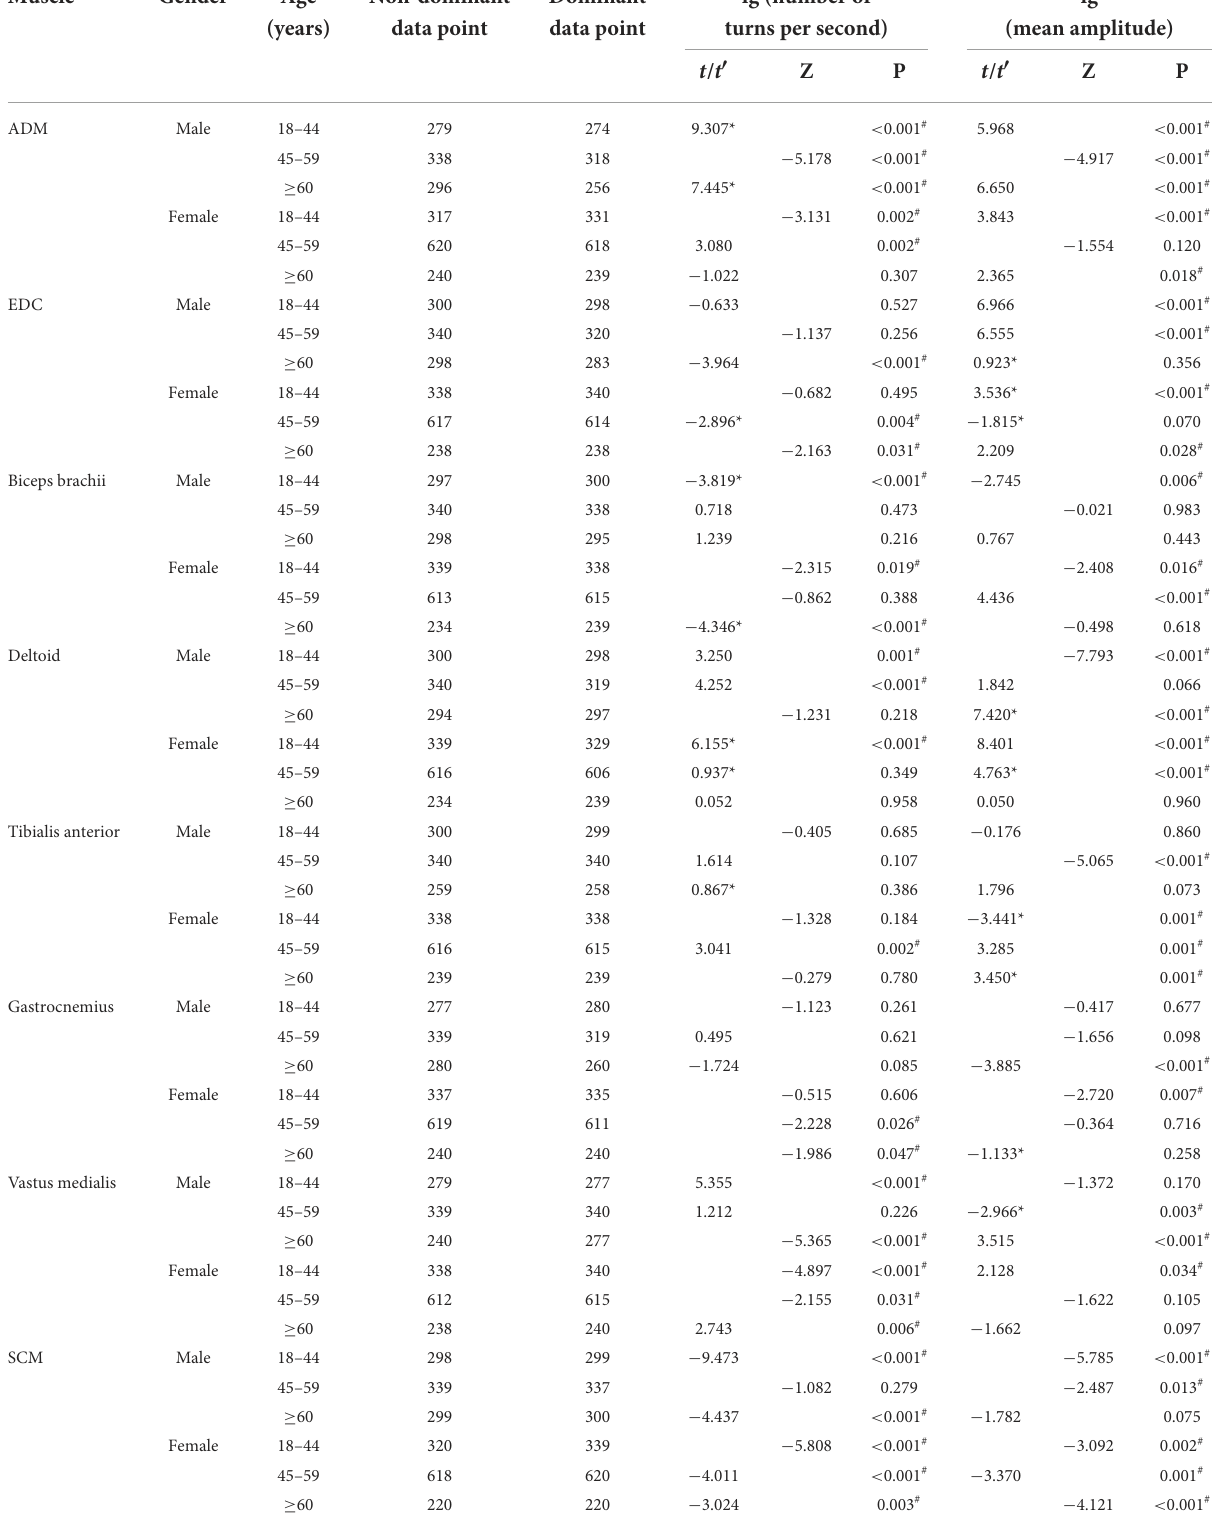
TABLE 5 The comparison of the results of lg (number of turns per second) and lg (mean amplitude) for the non-dominant and dominant muscles.